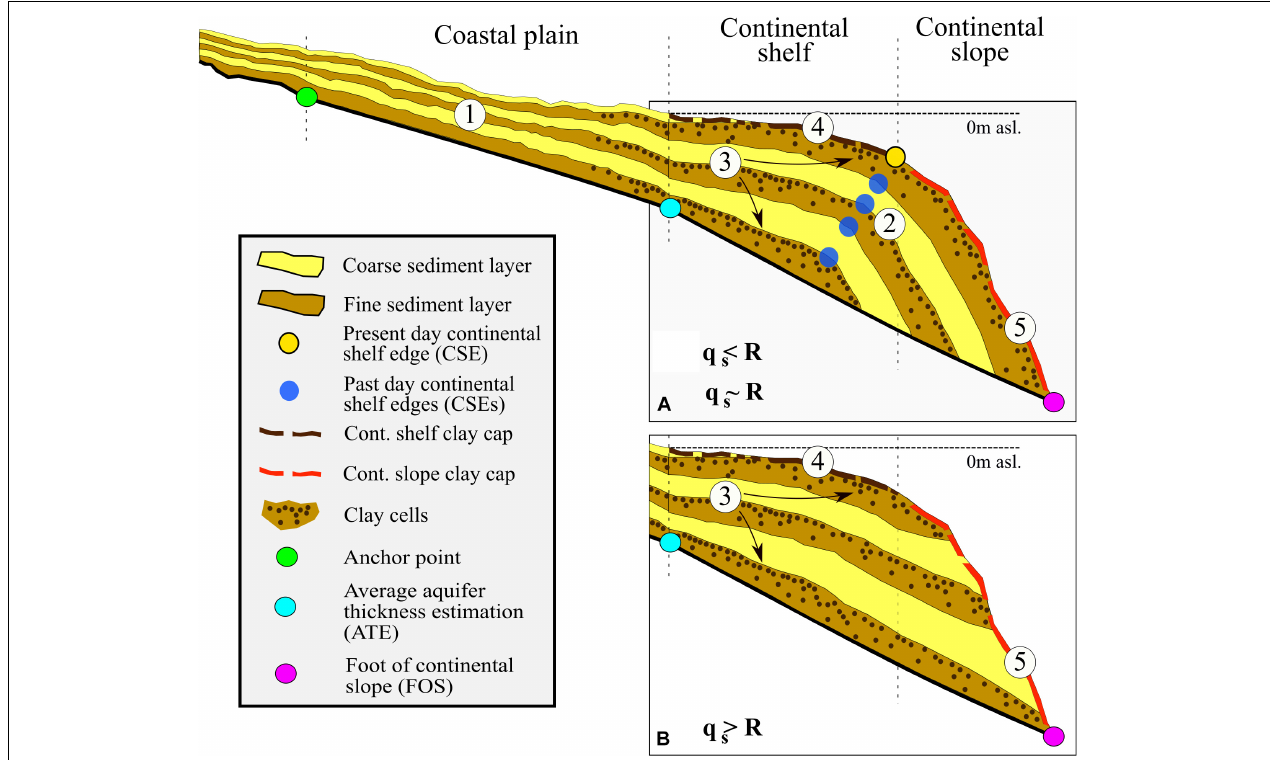
FIGURE 4 | Conceptual schematization showing the process of translating the geological information and parameter values into a synthetic heterogenic CUGS profile. (1) The total number of high stand (coarser sediments/aquifers) and low stand (finer sediments/aquitards) layer pairs is determined on sediment sand/mud composition ratio R specified in section “Global Geological Heterogeneity Parameterization.” (2) The offshore layers shape is based on the sediment flux parameter value q s ; in this example, the value is “high” meaning that the sediment supply is so high that the shelf edge is being pushed further away from the coastline (A) . In the opposite cases, the individual sediment layers are stacked on top of each other without fully over topping the lower layers (B) . (3) Assuming that during maximum high stand sea levels mostly very fine sediments are deposited (e.g., as during Holocene sea-level transgression; Oude Essink et al., 2010) both inland and offshore (due to low river gradient) individual clay layers (represented by model cells) are inserted into the larger fine sediment layers. A so-called stacking factor is applied to determine how close these model cells containing clay are placed relative to the top of the fine sediment layer. (4) A clay cap layer is potentially placed on top of the ocean floor depending on the main sediment type as provided by Dutkiewicz et al. (2015). (5) Same as in (4) but in the continental slope area.